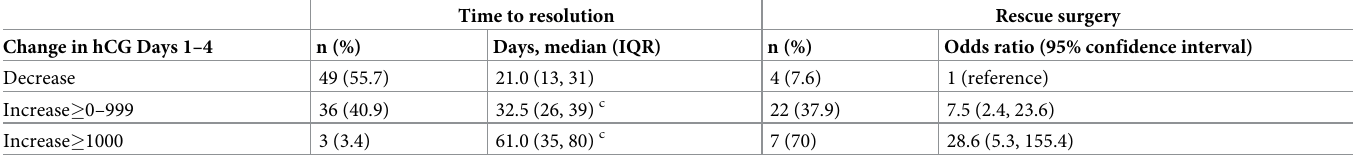
Table 3. Time to resolution and likelihood of surgical excision by the change in hCG from Days 1 to